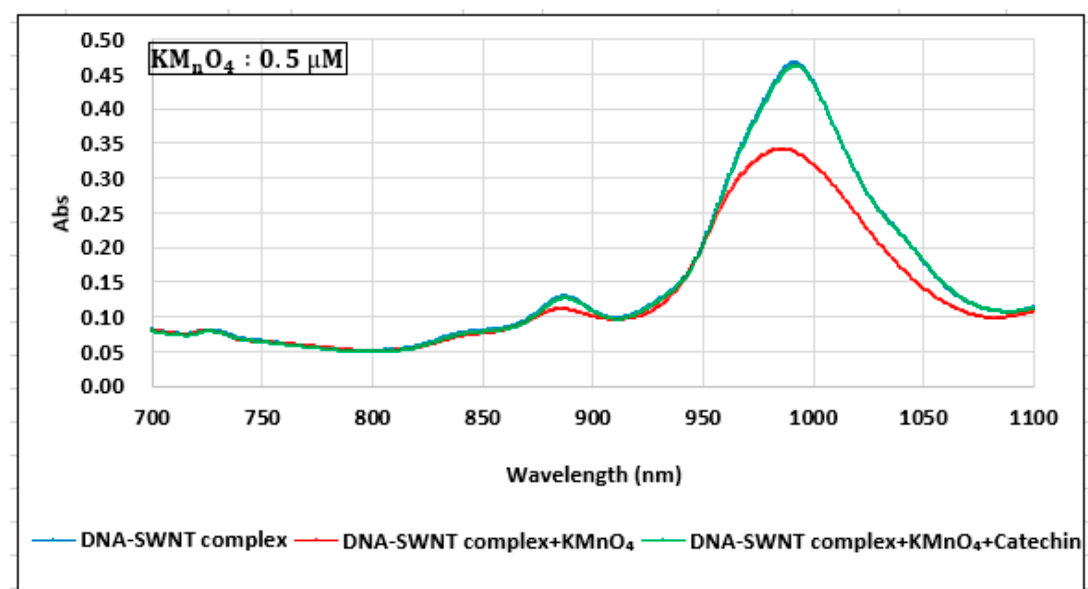
Figure 3. Absorption spectra of DNA-SWNT complex with KMnO 4 and catechin. The absorption peak decreased by 23.9% following the addition of KMnO 4 , and recovered by 30.7% as a result of adding the catechin solution. Table 1. E ff ects of KMnO 4 concentration on the absorption spectra and shift in the peak position. These data are presented as the average of three independent experiments. The final catechin concentration was 6.2 mM. There was a correlation between KMnO 4 concentration and the extent of the redox reaction. KMnO 4